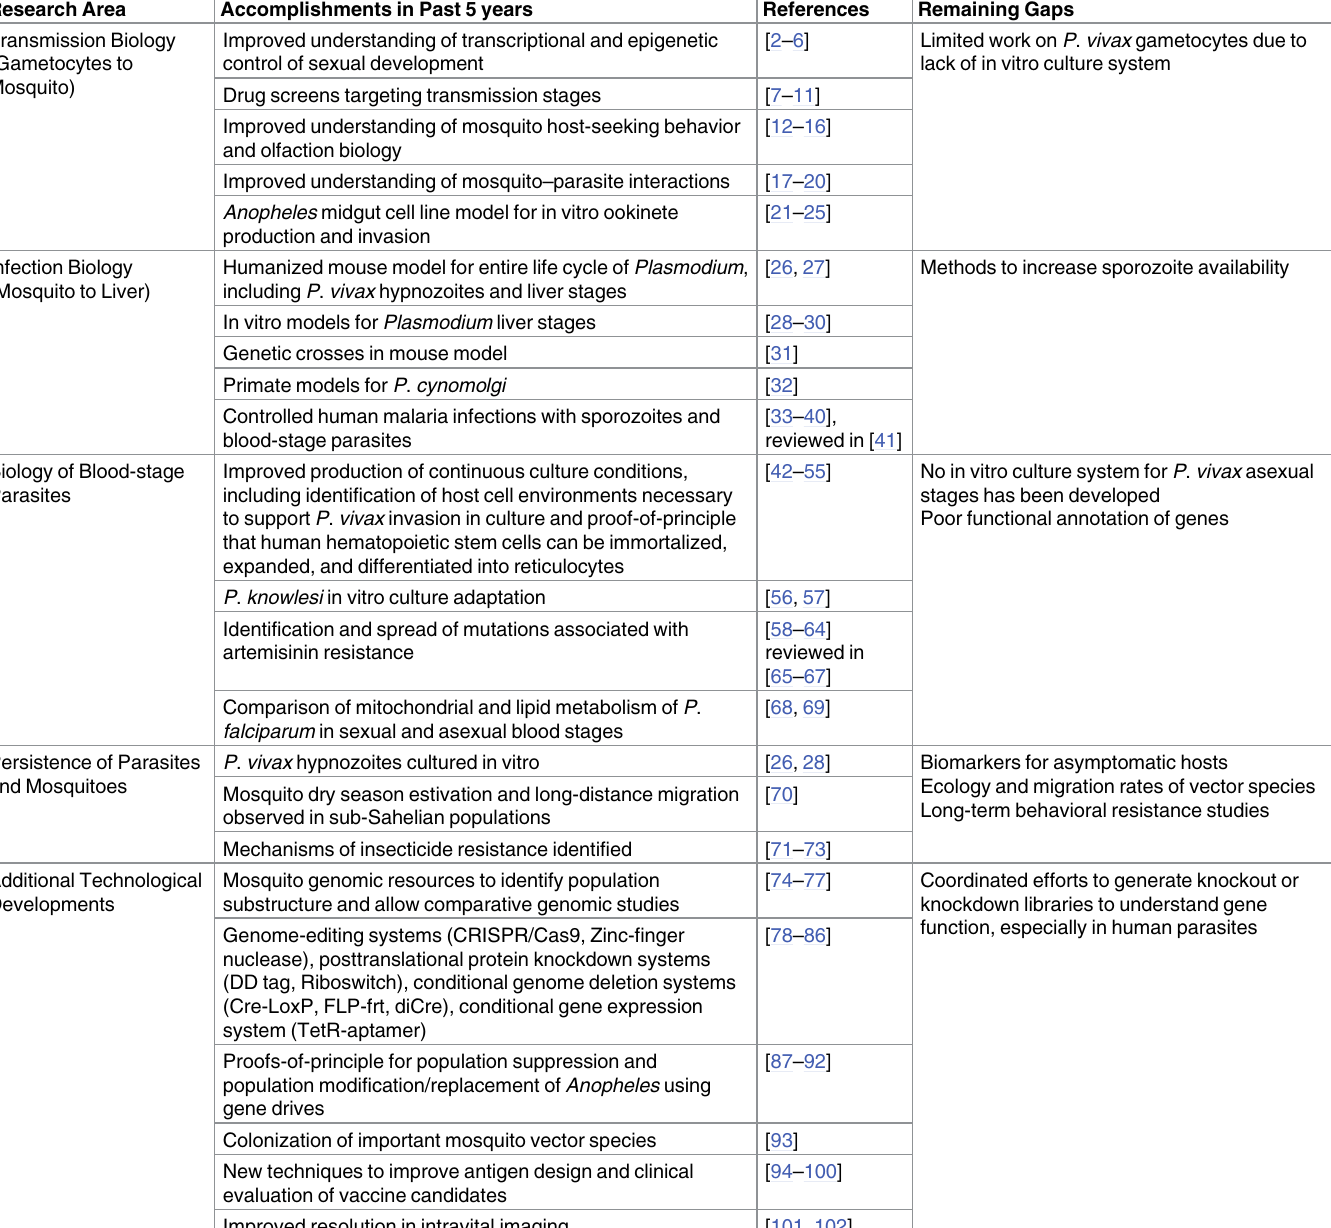
Table 1. A listing of the important research areas highlighted in malERA 2011, the progress made since then, and the remaining areasthat require additional